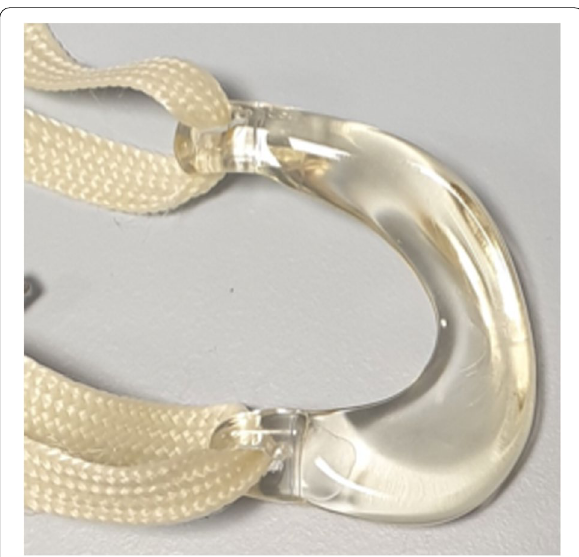
Fig. 2 Second-generation meniscus prosthesis, with strong horns, a flexible body and an anchoring